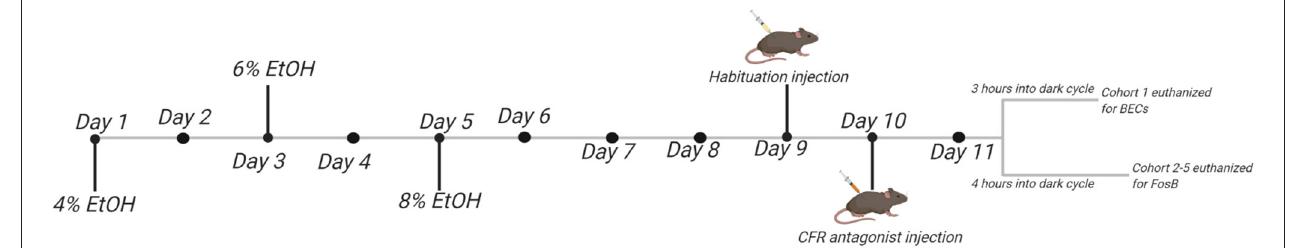
FIGURE 1 | Schematic of experimental